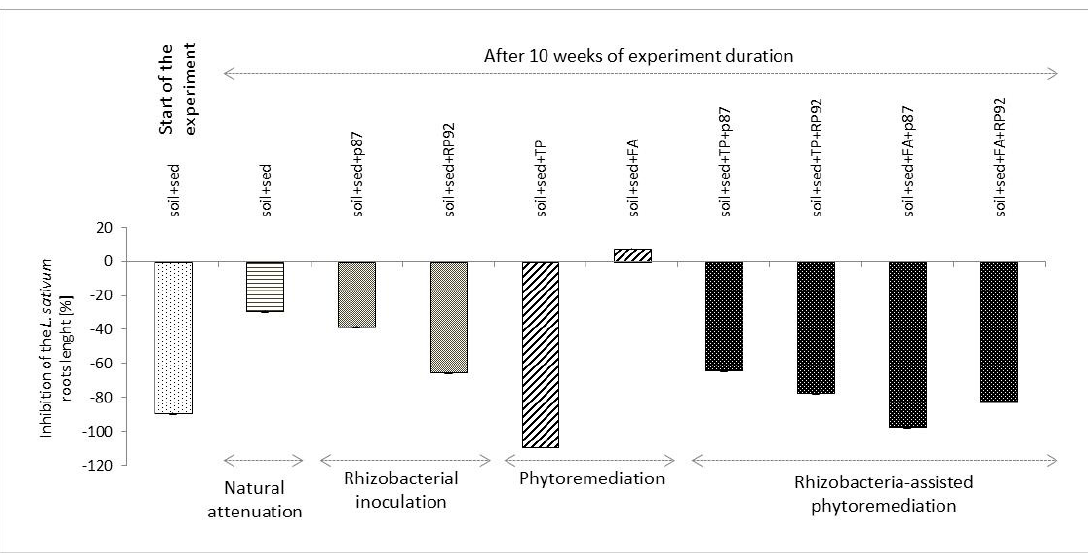
Figure 2. The effect of applied bioremediation strategies on soil phytotoxicity (negative values indicate stimulation of plant root growth).